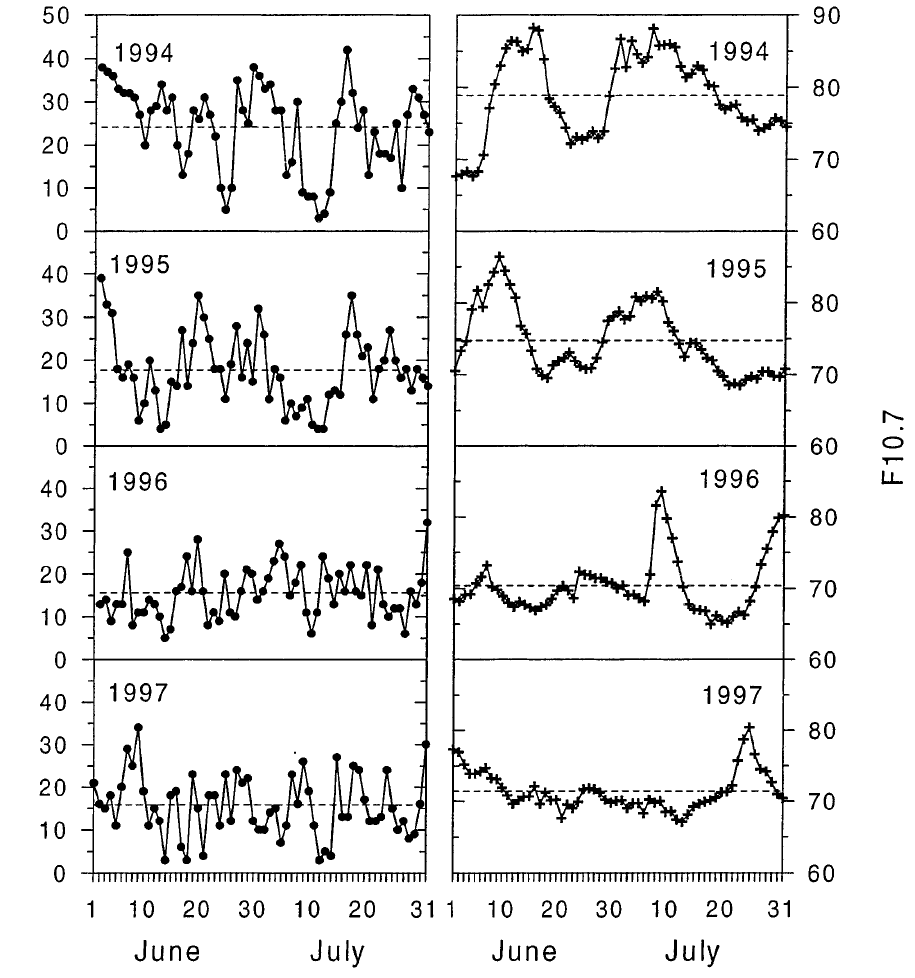
Fig. 1. Variation of geomagnet- ic activity (daily sum of eight 3- hourly K values, S K) of Tromsø ( left ) and of solar 10.7 cm radio flux ( right ) for the months June and July 1994–1997. The dashed lines are the mean values for the